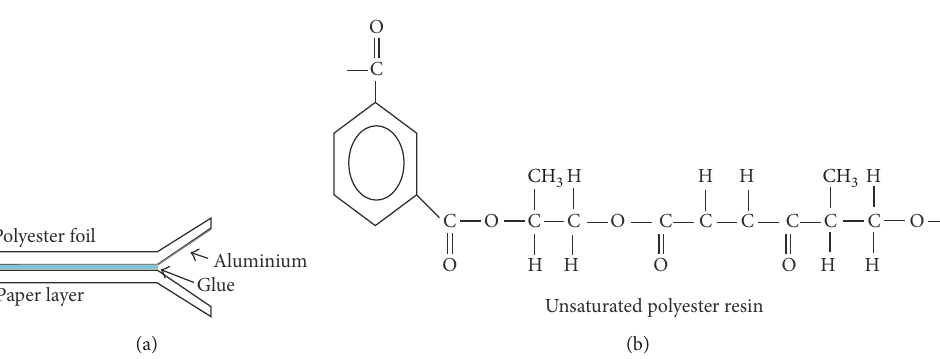
Figure 1: (a) Polyester used as top layer in composite production. (b) Schematic picture of the examined